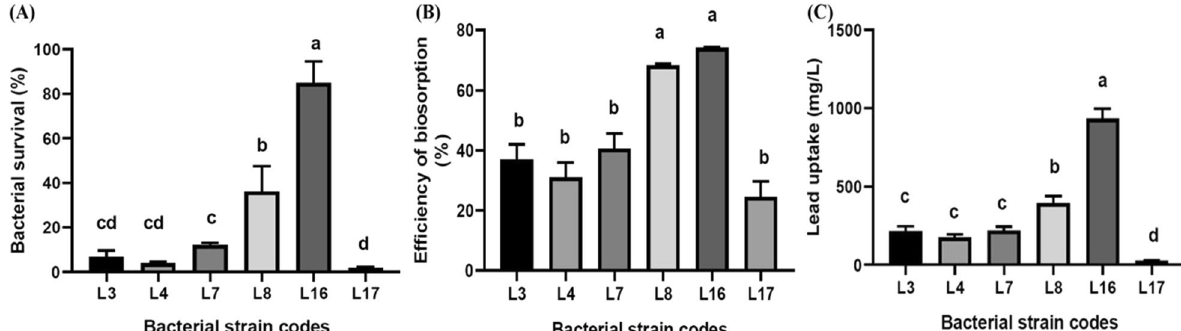
Fig. 2 Evaluating the ability of the selected bacterial strains to resist lead through determination of bacterial survival (%) on lead stress ( A ), effeciency of biosorption (%) ( B ) and lead uptake (mg/L) ( C ). L3: Enterobacter ludwigii , L4: Shigella flexneri , L7: Microbacterium paraoxydans , L8: Klebsiella pneumoniae subsp. pneumoniae , L16: Raoultella planticola and L17: Staphylococcus xylosus